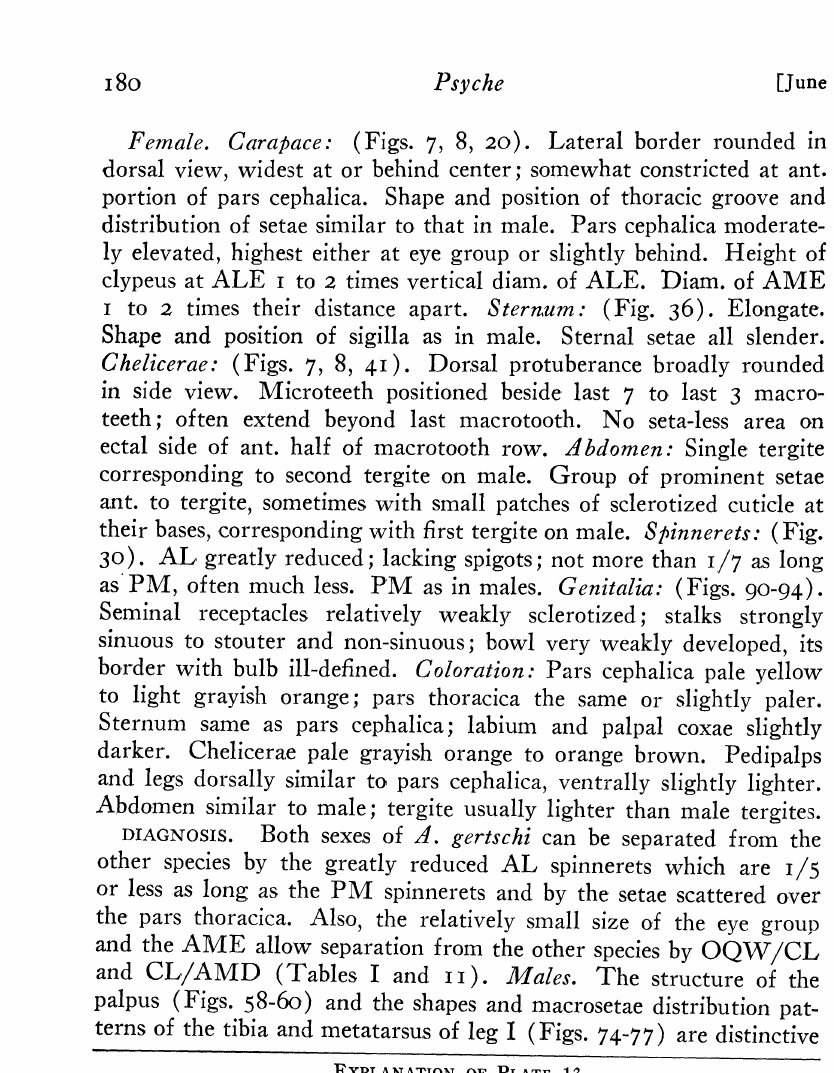
in ram. For scatter diagrams solid black dots represent P specimens, represent M specimens.) 61-63. Males. 61. Mod. Dice-Leraas diagram CL variation. 62. Scatter diagram of ITarL plotted against CL. 63. Scatter diagram of IML plotted against CL. 64-67. Females. 64. Histogram ICTR. (One unit of vertical scale represents a single specimen.) gram of CT. (One unit of vertical scale represents a single che]icera.) 66. Mod. Dice-Leraas diagram of CT/ICTR variation. 67. Scatter diagram of IVTL plotted against